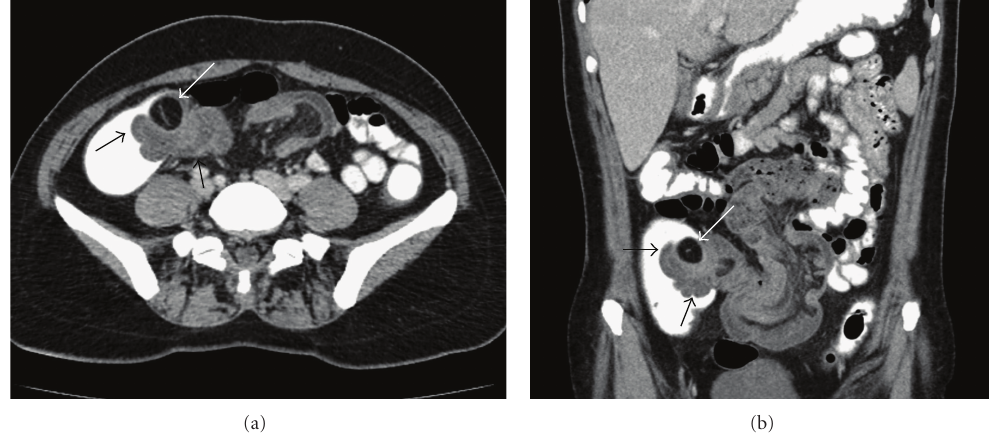
Figure 2: (a) Axial and (b) coronal plan intravenous contrast-enhanced CT scans with oral and rectal contrast demonstrate an ileocolic intussusception with di ff use wall thickening of terminal ileum and the entrance of ileal segment into the cecum at the ileocecal valve level (black arrows). In the cecum adjacent to invaginated segment, hypodense mass lesion consistent with lipoma is seen (white